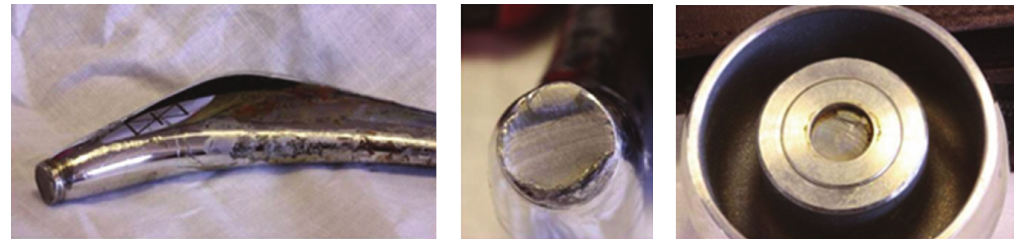
Figure 2: Photographs of the explanted femoral component, demonstrating the fracture at the head-neck junction (left to right: proximal femoral stem, cross section of the fracture site, under surface of the femoral head).